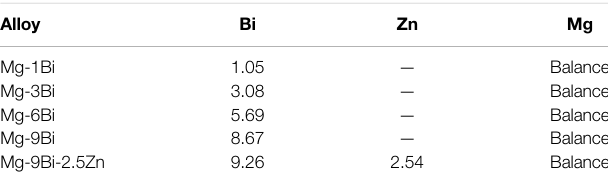
TABLE 1 | Composition of the alloys studied in this work expressed in weight percentage.